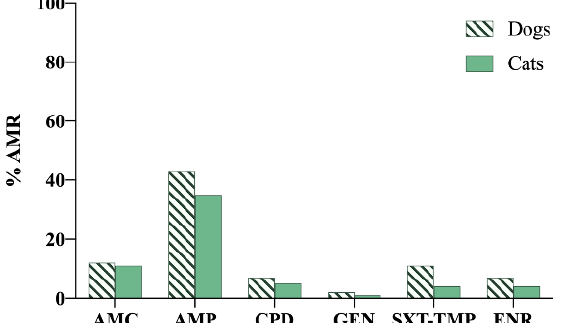
Figure 3. Antimicrobial resistance (AMR) prevalence in Escherichia coli isolated from dogs and cats in Finland. AMC: amoxicillin – clavulanic acid; AMP: ampicillin; CPD: cefpodoxime; GEN: gentami- cin; SXT-TMP: sulfamethoxazole – trimethoprim; ENR: enrofloxacin.